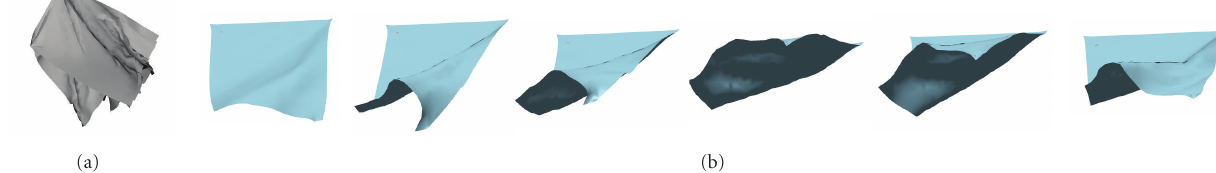
Figure 9: Editing of highly nonrigid objects. (a) We provide 14 examples (1k triangles) to edit a cloth. (b) By just dragging the lower right corner of the model to apply translations, we can animate the cloth